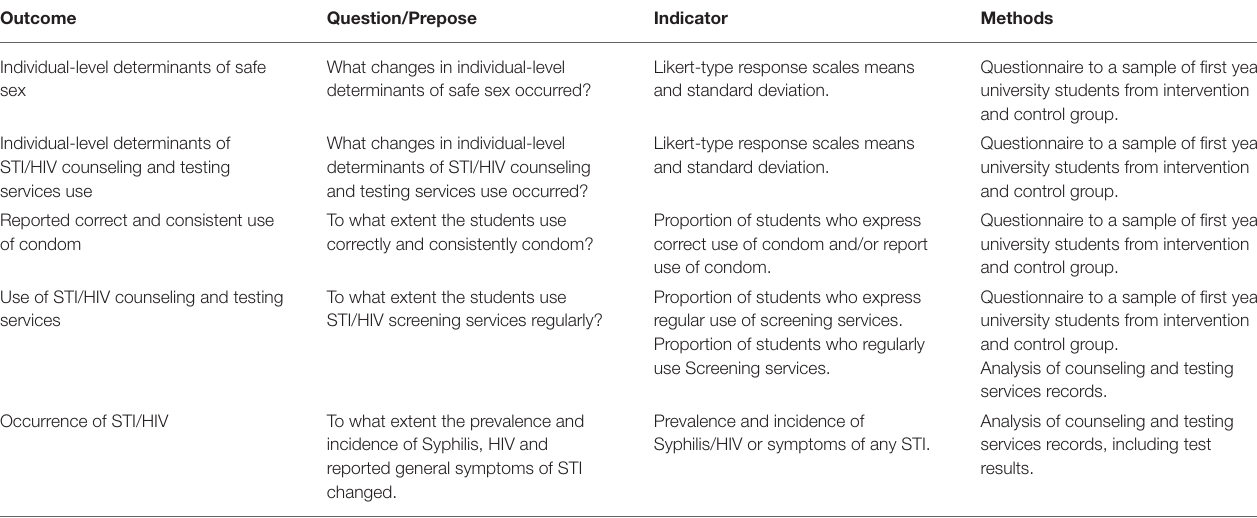
TABLE 2 | Effect evaluation overview for the “Take the opportunity to listen and to be listened to!” Outcome Question/Prepose